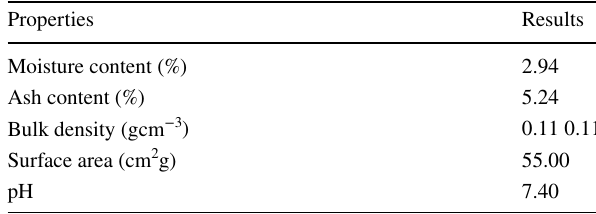
Table 1 Physicochemical properties of MSC Properties